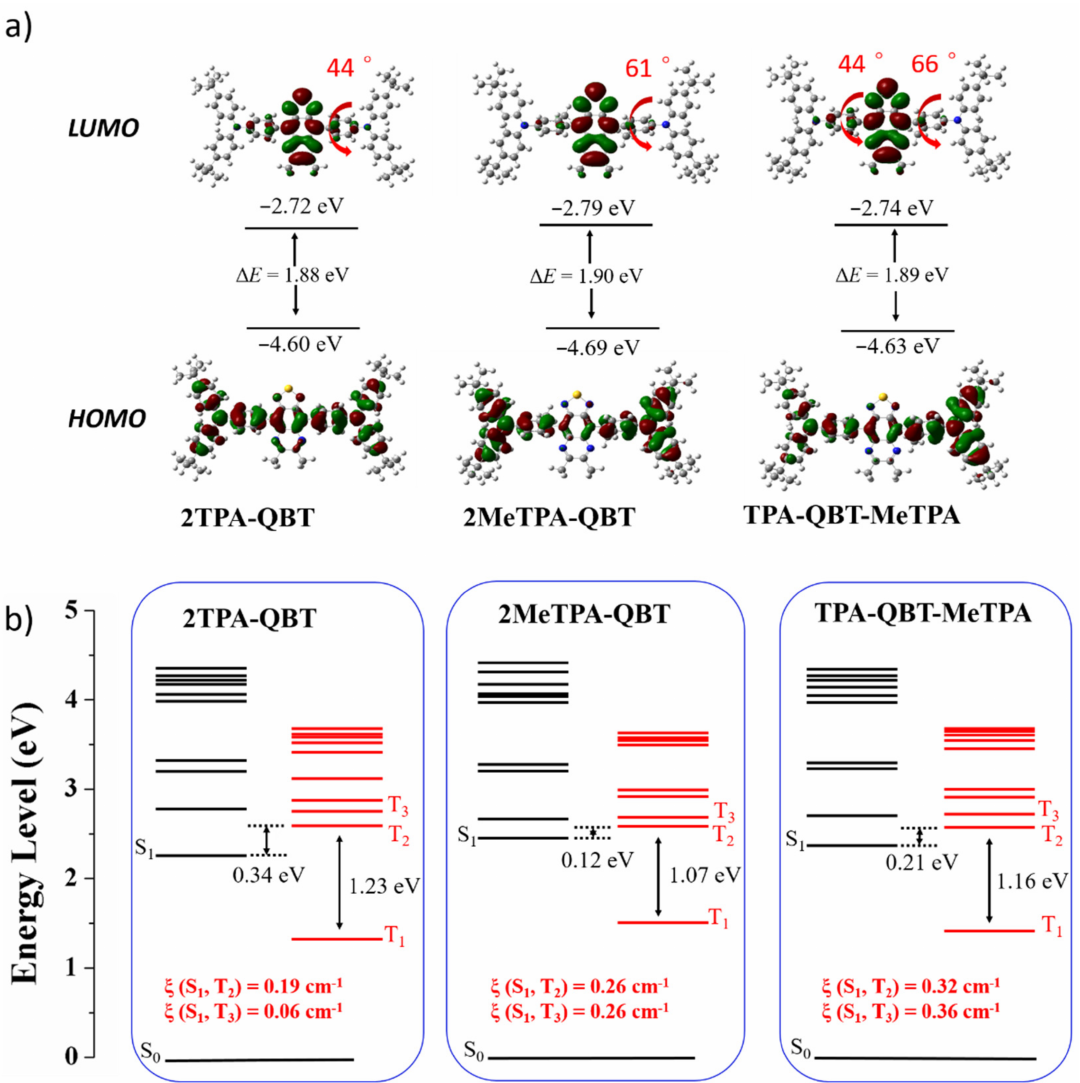
Figure 6. ( a ) Optimized structure and calculated HOMO/LUMO spatial distributions and ( b ) energy level diagrams of